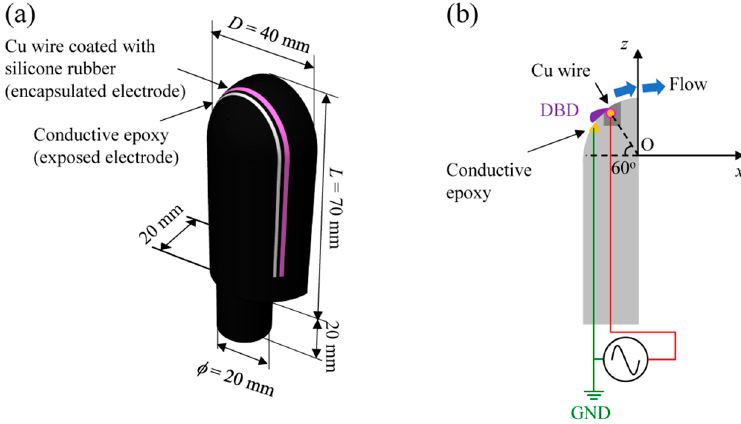
Figure 2. ( a ) External view of car door mirror model, and ( b ) internal structures in the x – z cross